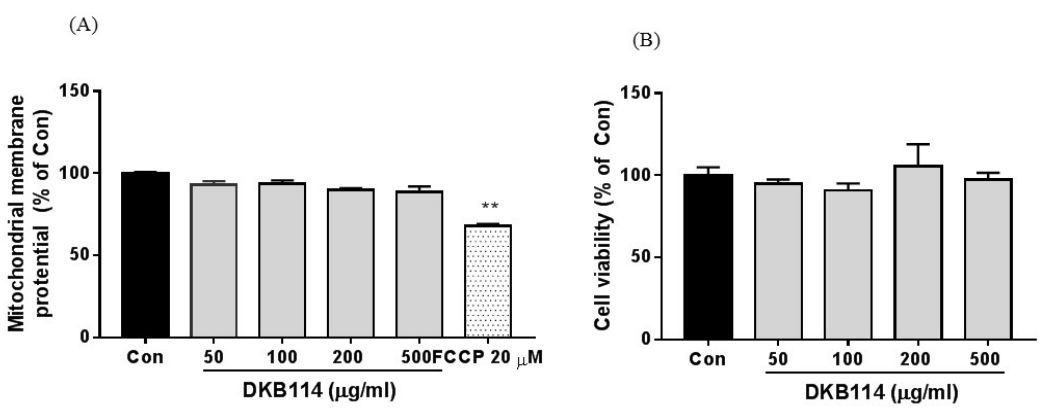
Figure 5. Effects of DKB114 on mitochondrial toxicity in HepG2 cells. ( A ) Mitochondrial membrane potential (MMP) and ( B ) cell viability. MMP and cell viability in HepG2 cells were analyzed as described in the Materials and Methods. Con: untreated cells; DKB114, a mixture of ethanol extracts of Chrysanthemum indicum Linne flower (CF) and Cinnamomum cassia (L.) J. Presl bark (CB) in a 1:2 ratio. FCCP: Carbonyl cyanide 4-(trifluoromethoxy) phenylhydrazone). Data are expressed as the mean ± SEM ( n = 4) and are representative of three independent experiments. ). ** p < 0.01 vs. the control group.